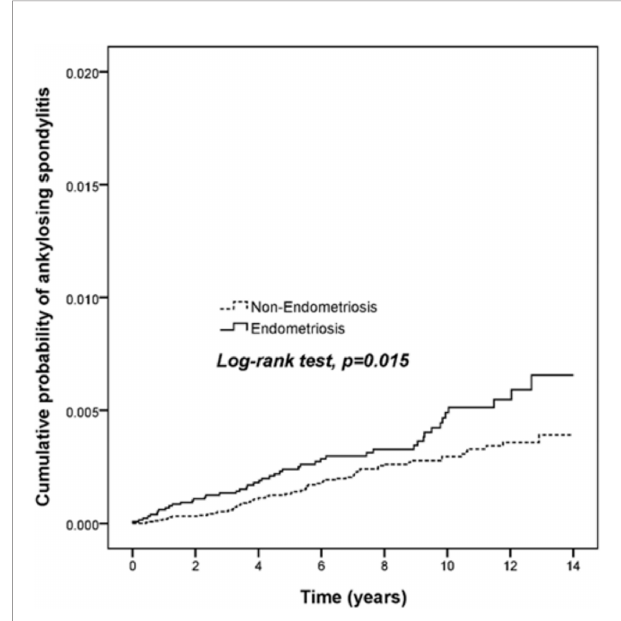
FIGURE 2 | Endometriosis patients display a higher risk for ankylosing spondylitis. The cumulative probability among 13,145 endometriosis patients and 78,870 age and gender-matched comparison cohort was analyzed by log-rank